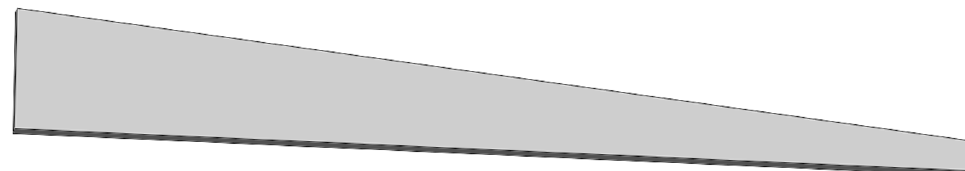
Figure 2. Normal/Plane section of a turbine blade. Table 1. Conditions for the normal section of the turbine blade.